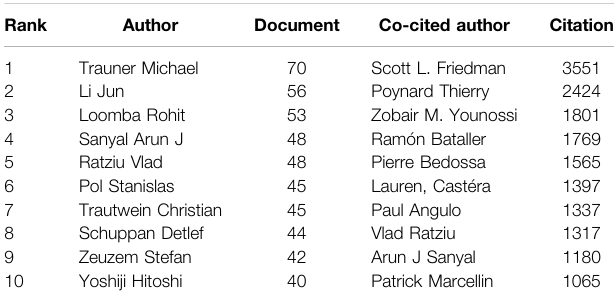
TABLE3| Thetop10authorsandco-citedauthorsrelatedtothetreatmentofliver fi